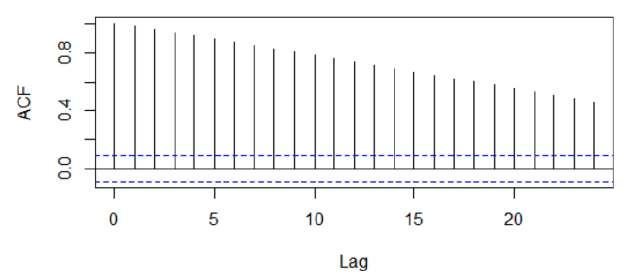
Figure 2: ACF plot of log